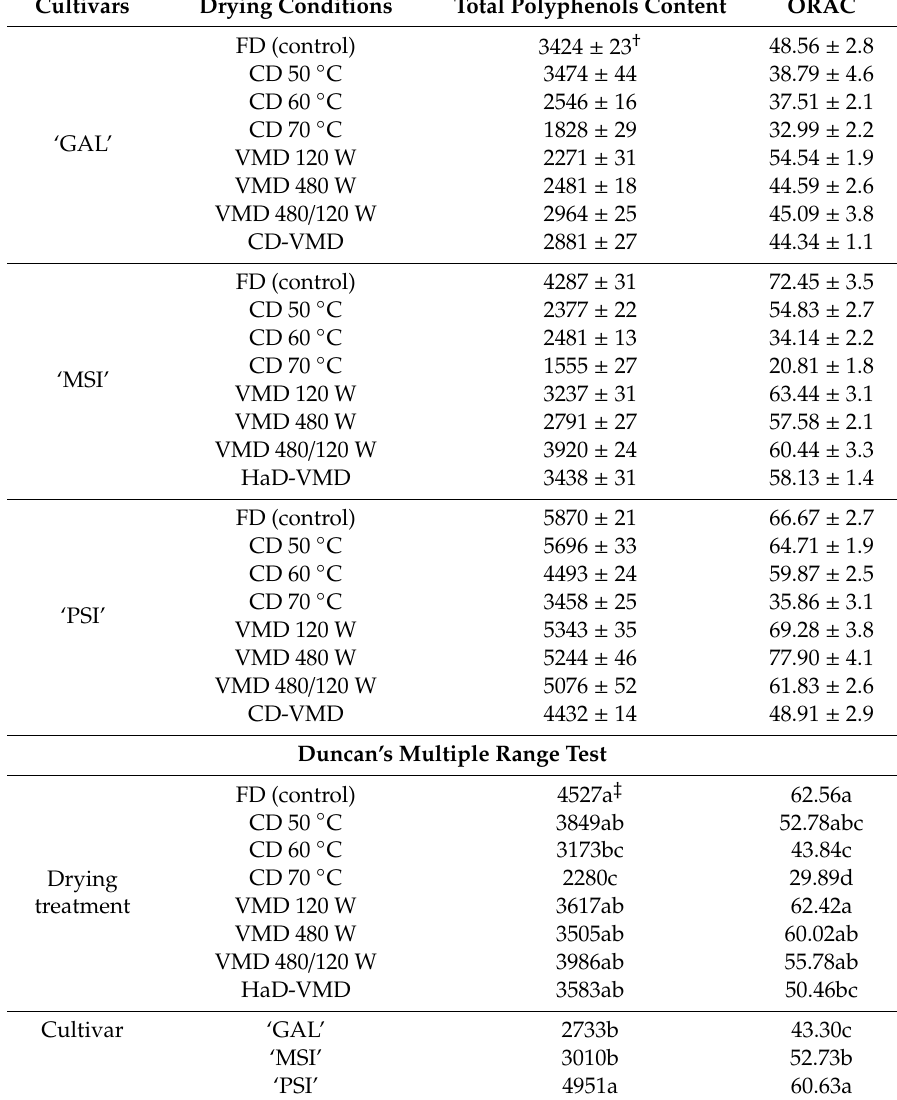
Table 3. The influence of di ff erent methods and parameters on the total phenolic content (mg / 100